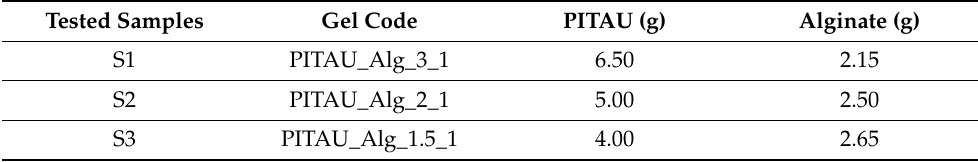
Table 3. Codification and chemical composition of the studied samples. Tested Samples Gel